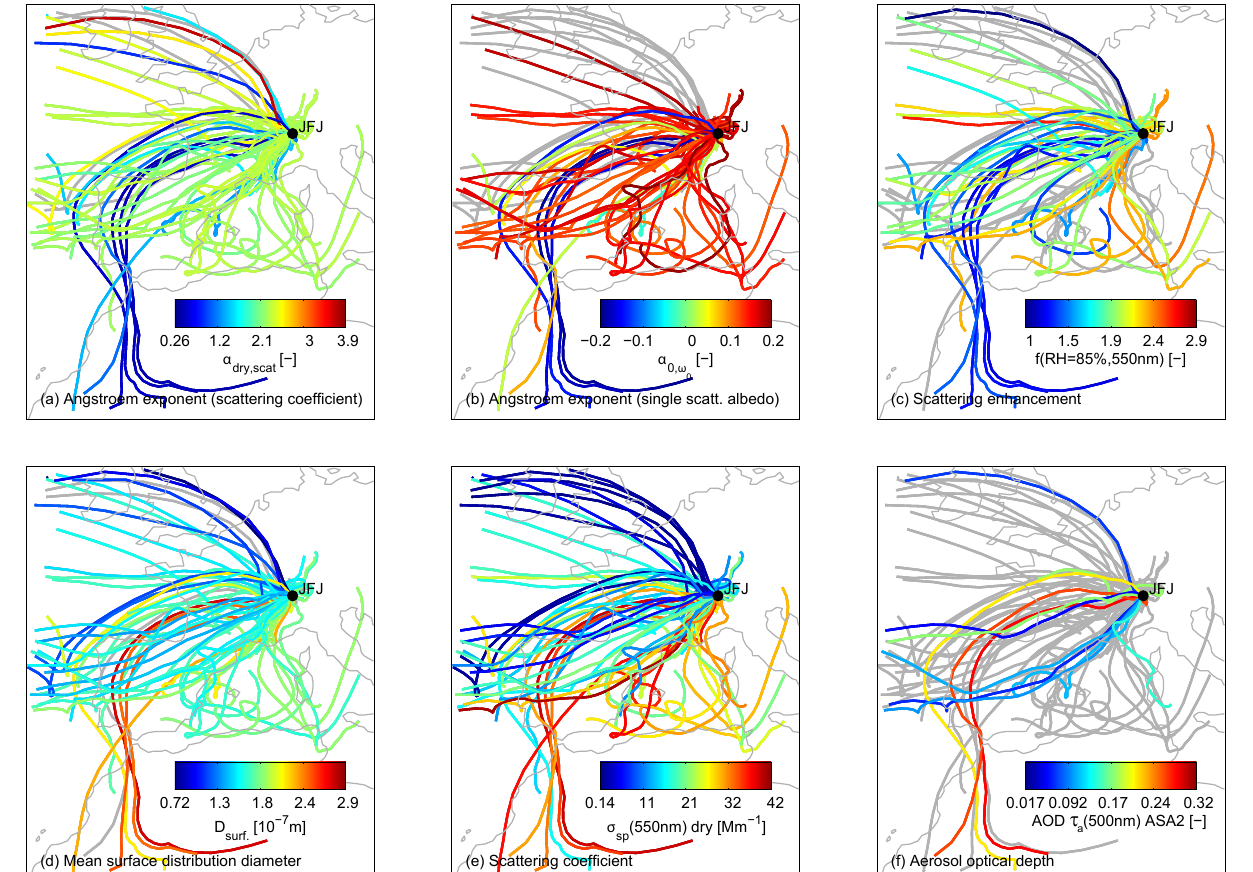
Fig. 2. FLEXTRA air mass trajectories (5-day backward calculations with the Jungfraujoch (JFJ) as endpoint) for the intensive observation period (3–18 July 2010). The color code denotes the specific aerosol parameter measured at the time the air parcel arrived at the site: (a) ˚Angstr¨om exponent of the dry scattering coefficient; (b) ˚Angstr¨om exponent of the dry single scattering albedo (Saharan dust index); (c) scattering enhancement factor at 85% relative humidity; (d) mean surface diameter; (e) scattering coefficient (dry); (f) aerosol optical depth measured from the Kleine Scheidegg by FUBISS-ASA2. Grey lines are trajectories without data (e.g. in cloudy situations or when measurements are below detection limit or during